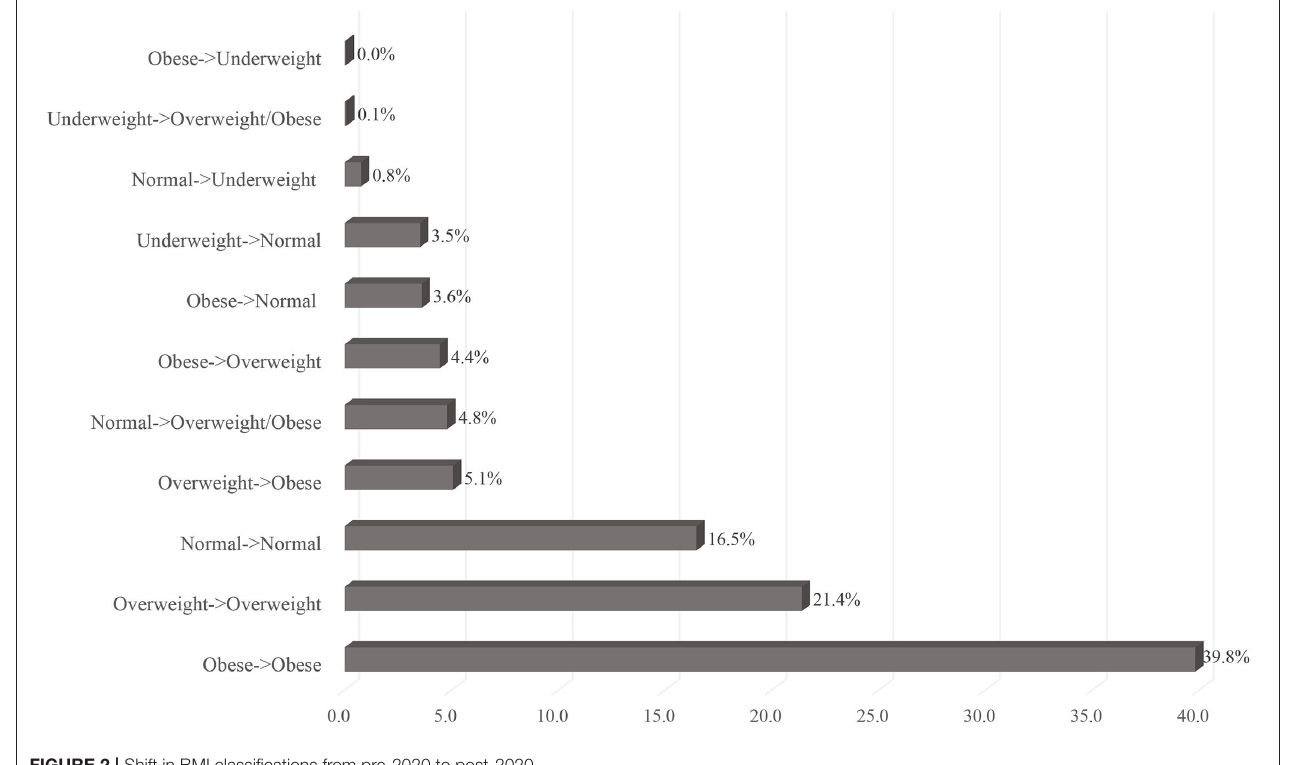
FIGURE 2 | Shift in BMI classifications from pre-2020 to post-2020.